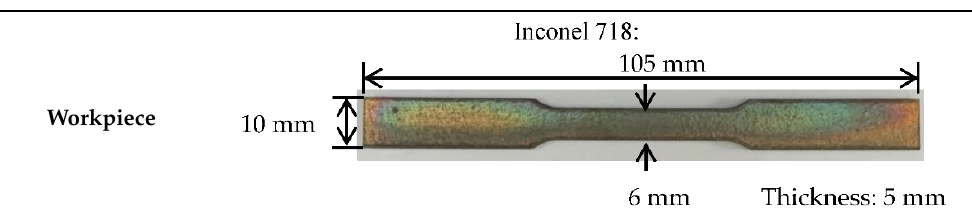
Table 4. MAF experimental conditions.